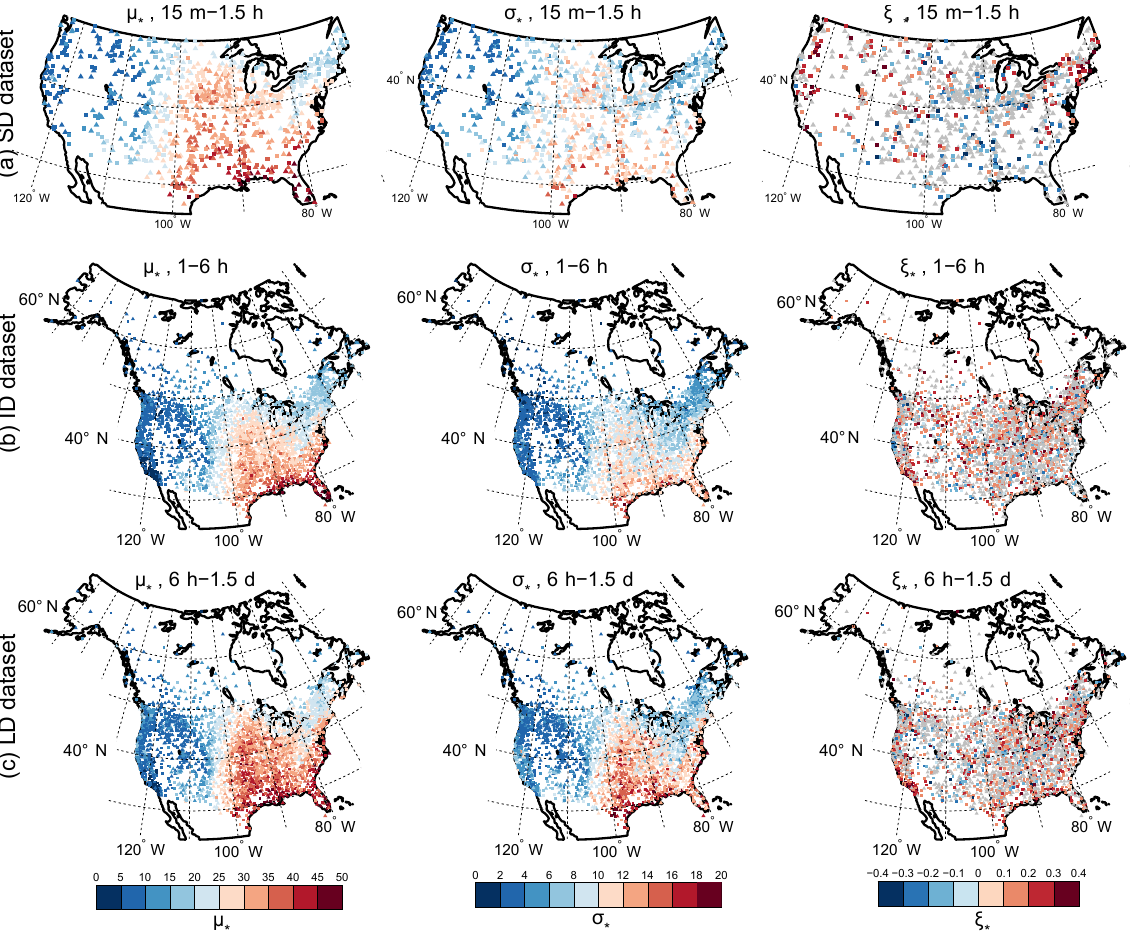
Figure 10. Spatial distribution over valid SS stations of SS GEV position (first column), scale (second column), and shape (third column; grey symbols indicate Gumbel distributions, ξ ∗ = 0) parameters scaled at d ∗ = 1h for the first 6-duration scaling interval (i.e., interval with minimum d 1 ) of SD (a) , ID (b) , and LD (c)